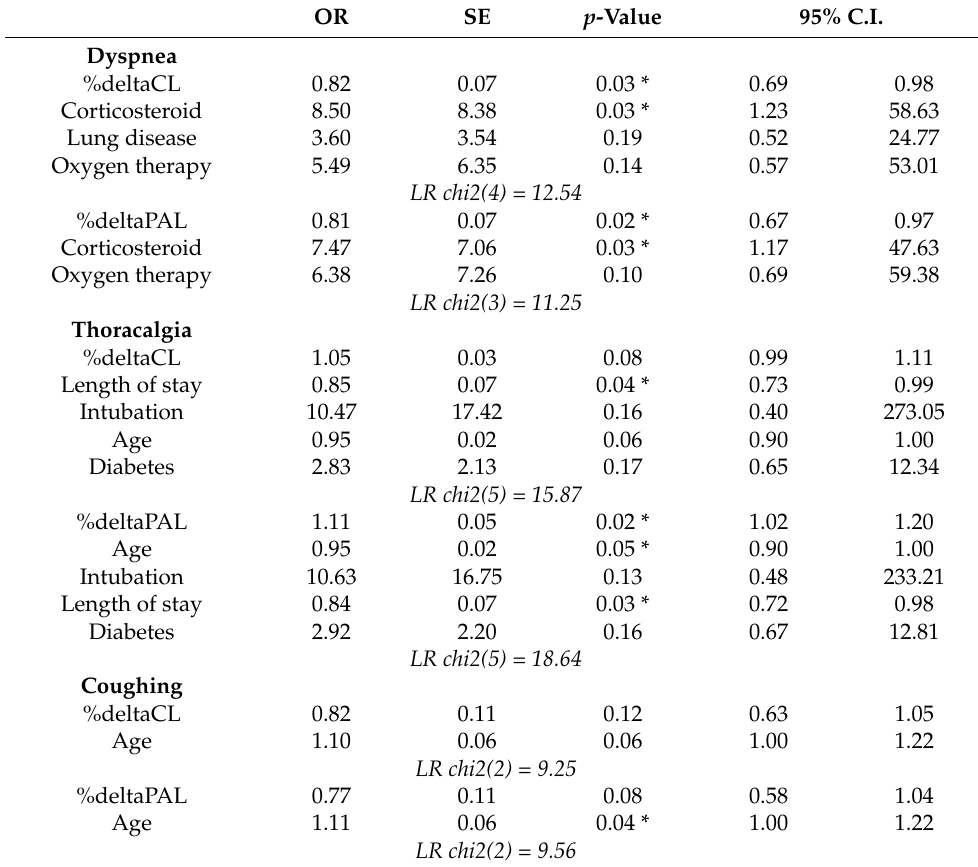
Table 2. Results from logistic regression